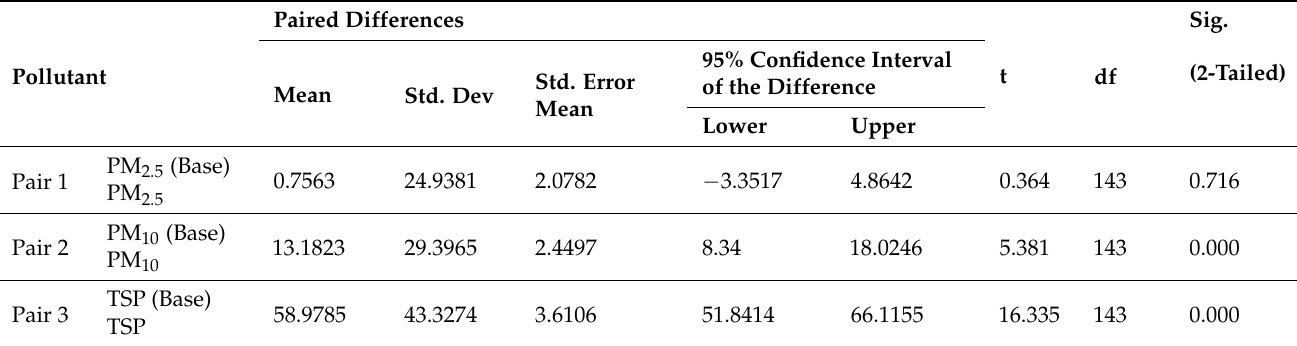
Table 2. Paired sample